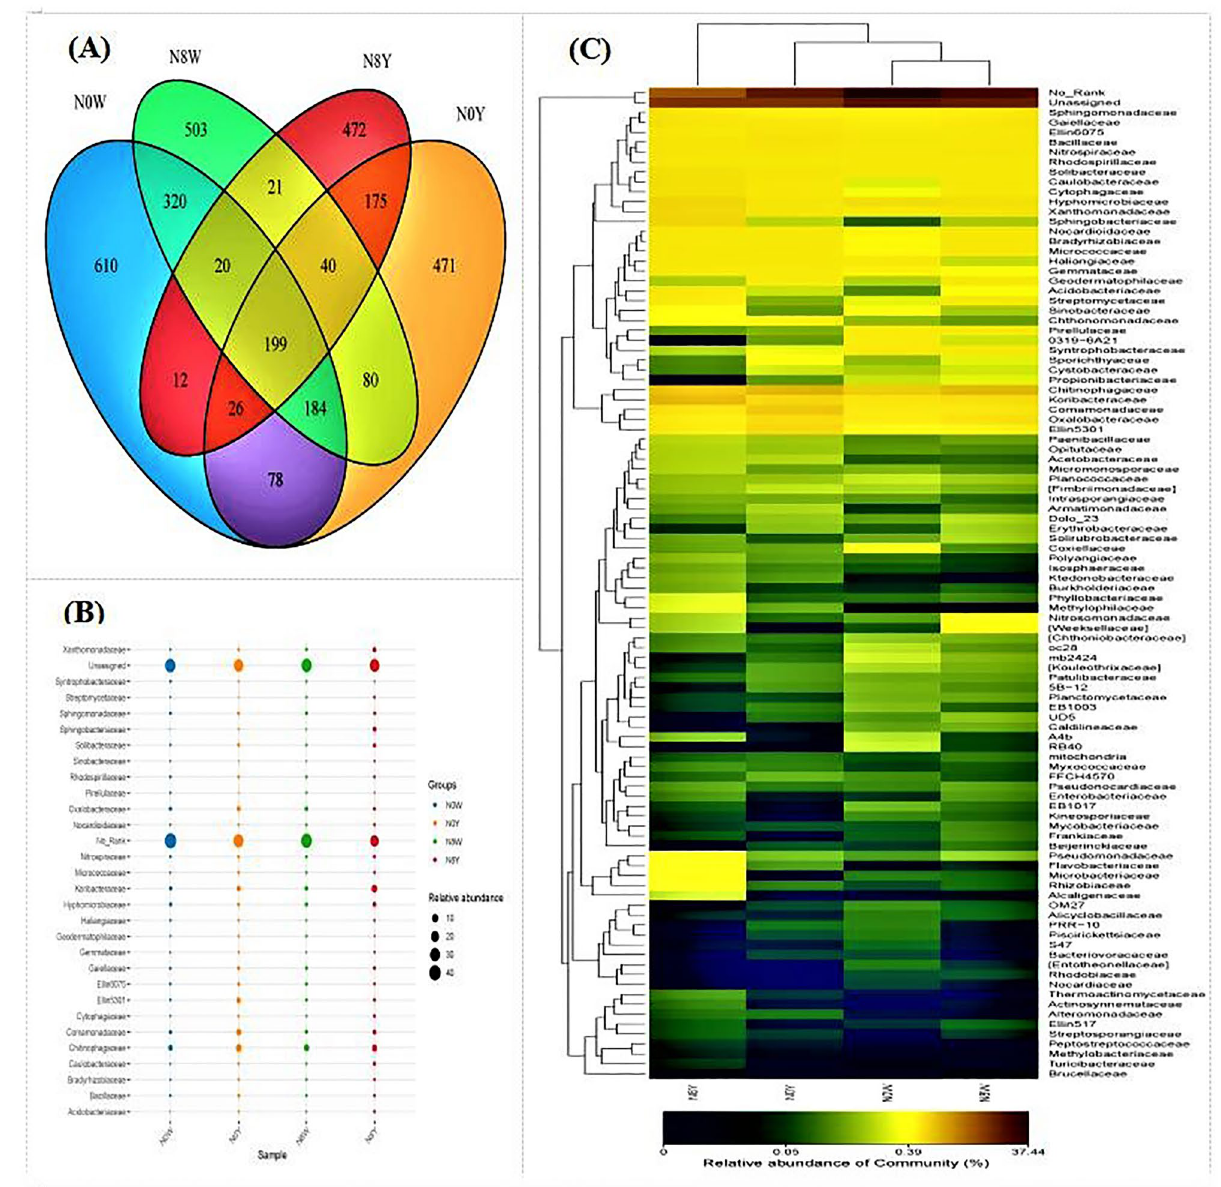
( C ) Cluster analysis heatmap of soil